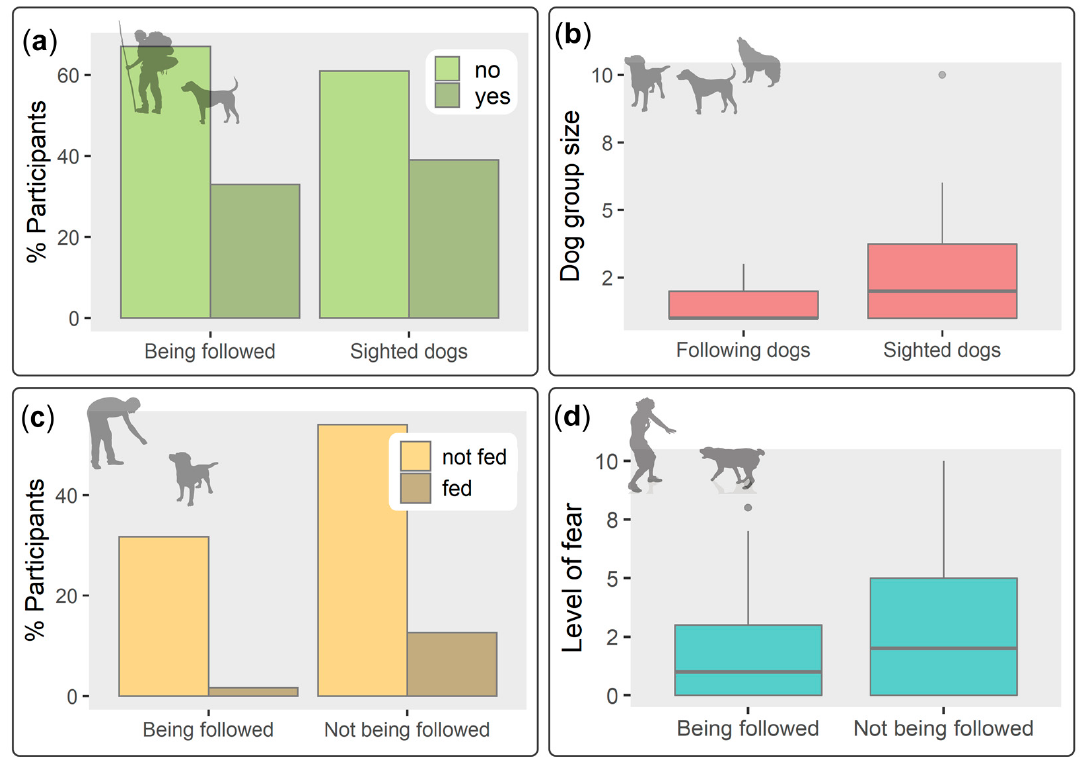
Figure 2. Principal questionnaire results of 81 tourists on free-ranging dogs in southern Chile during summer 2015/2016: ( a ) Participants being followed by dogs ( n = 79) and having seen free-ranging dogs outside town ( n = 77); ( b ) group size of dogs having followed participants ( n = 21) and group size of sighted free-ranging dogs ( n = 27); ( c ) participants ( n = 63) being followed by dogs with respect to having them fed or not, and ( d ) participants ( n = 76) being followed by dogs with respect to their level of fear of free-ranging dogs (0 = no fear, 10 = high level of fear). Illustrations downloaded from Pixabay.com.